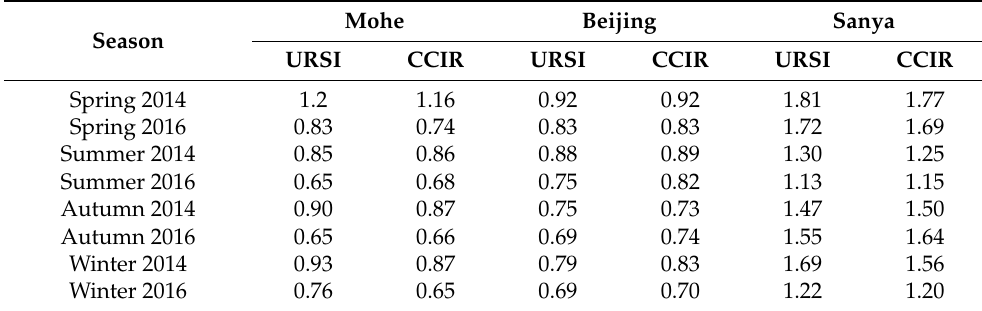
Table 3. Daily average RMS values of IRI-2016 URSI and CCIR predicted foF2 from the foF2 ionosonde observed in the four different seasons for the years 2014 and 2016 at Mohe, Beijing and Sanya over China (unit: MHZ). Mohe Beijing Sanya URSI CCIR URSI